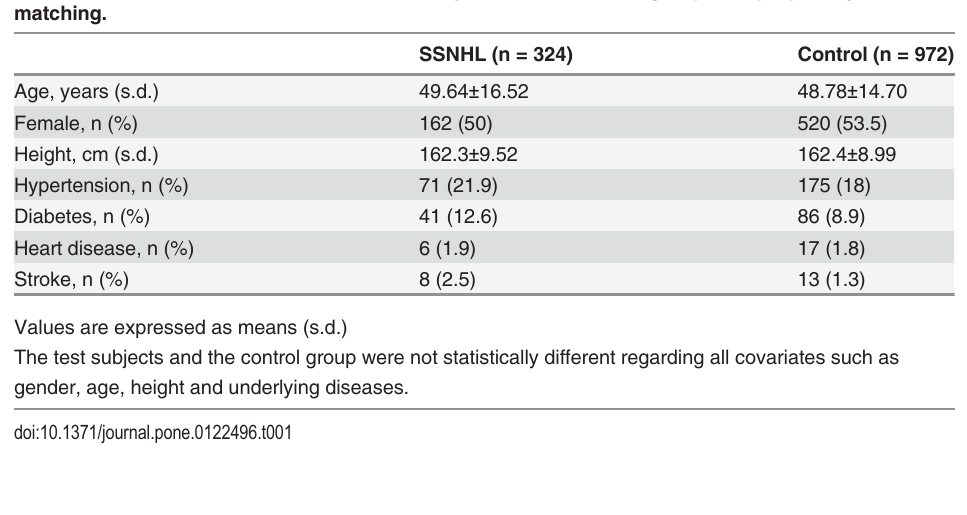
SSNHL (n = 324) Control (n = 972)